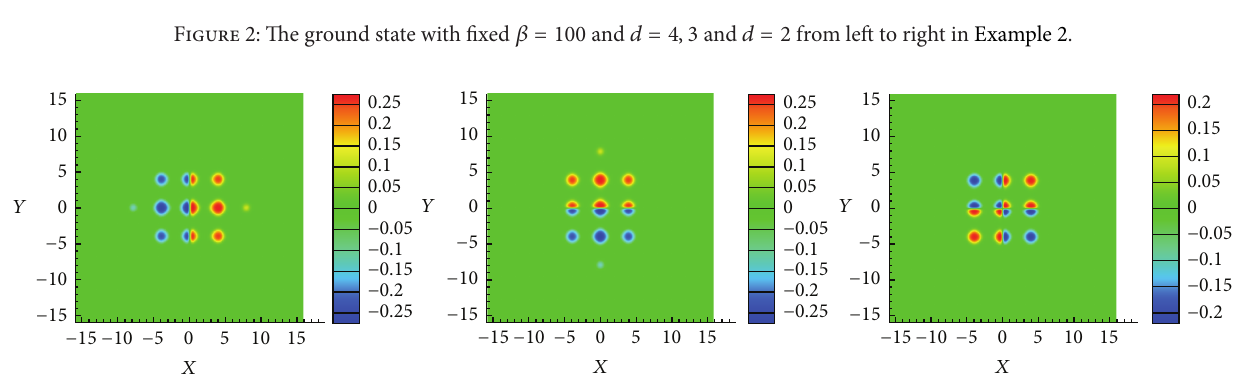
Figure 3: The first excited states in 𝑥 -direction, in 𝑦 -direction, and in 𝑥 and 𝑦 -direction from left to right in Example 2.